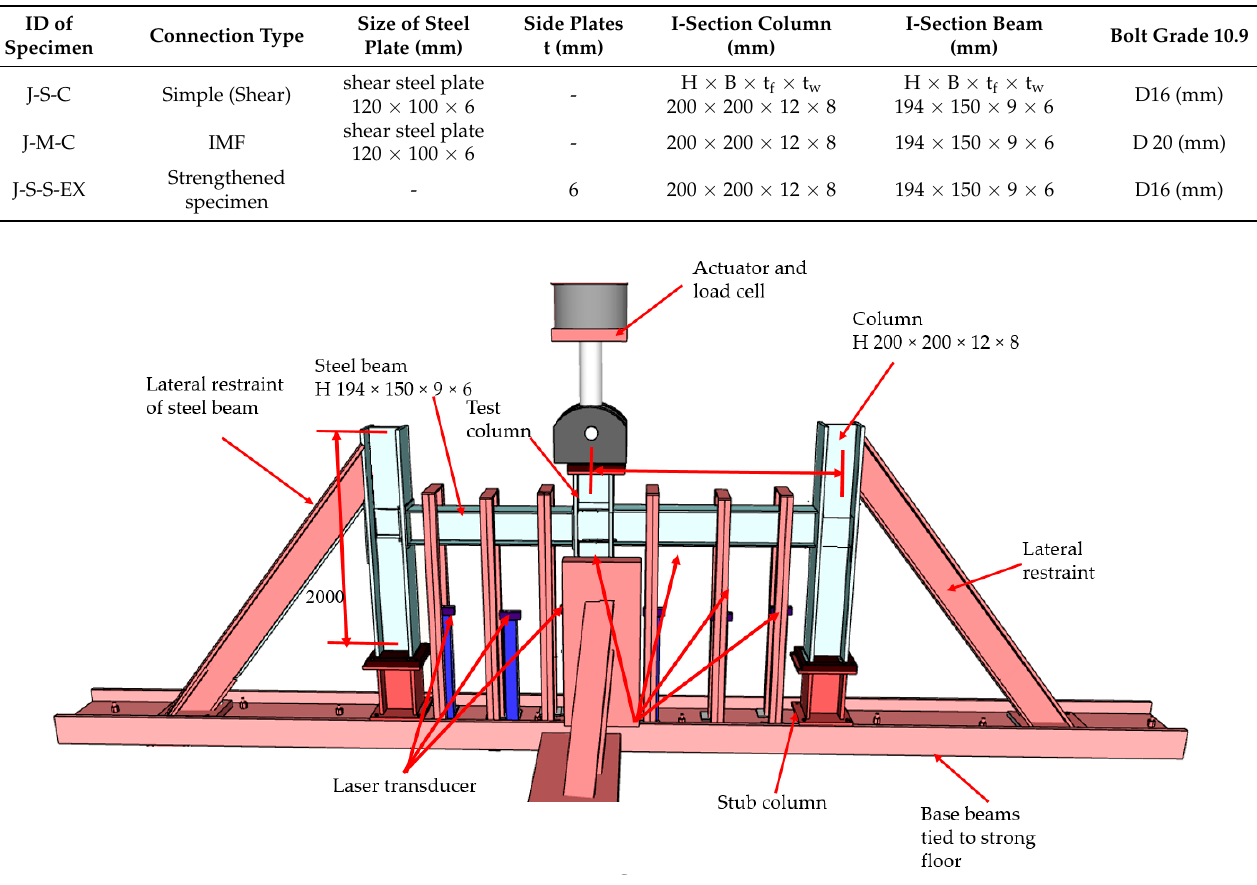
Figure 1. Details of test setup for steel frame.